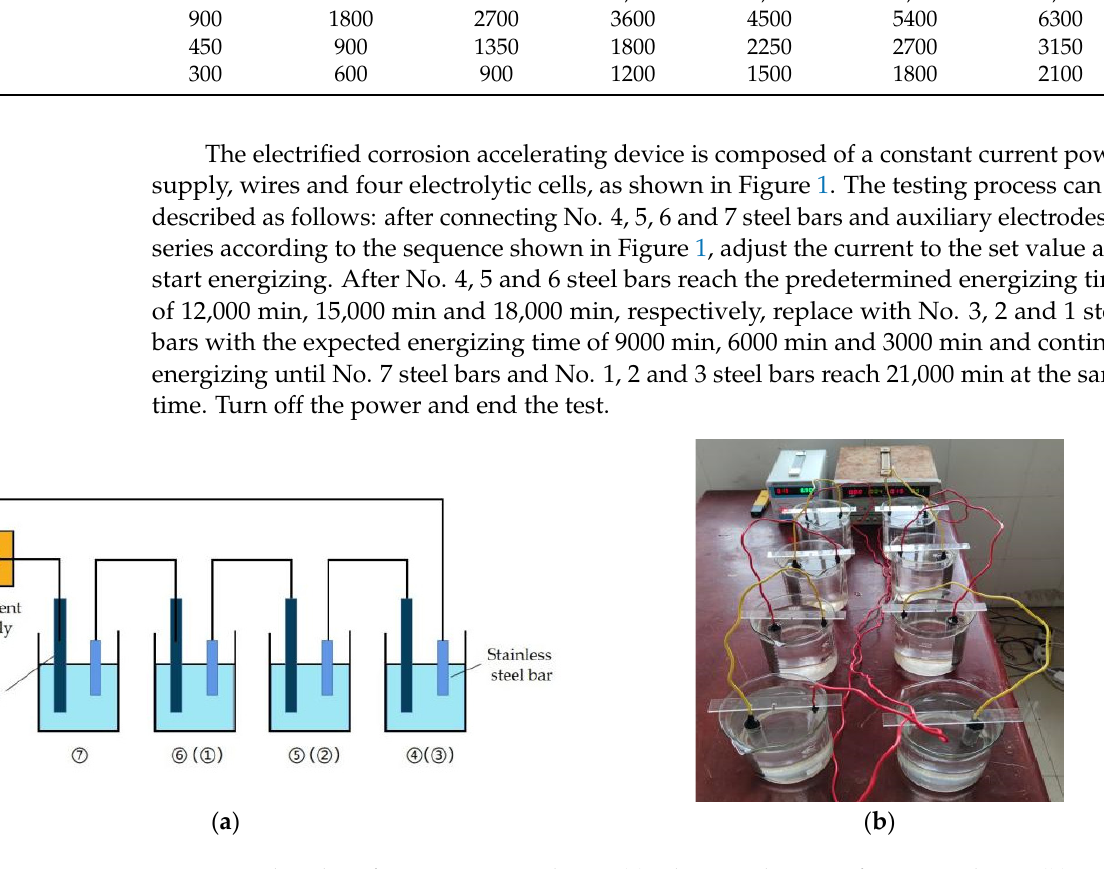
Figure 1. Rebar electrification corrosion device. (a) Schematic diagram of corrosion device; (b) Cor- rosion test of steel bar electrification.